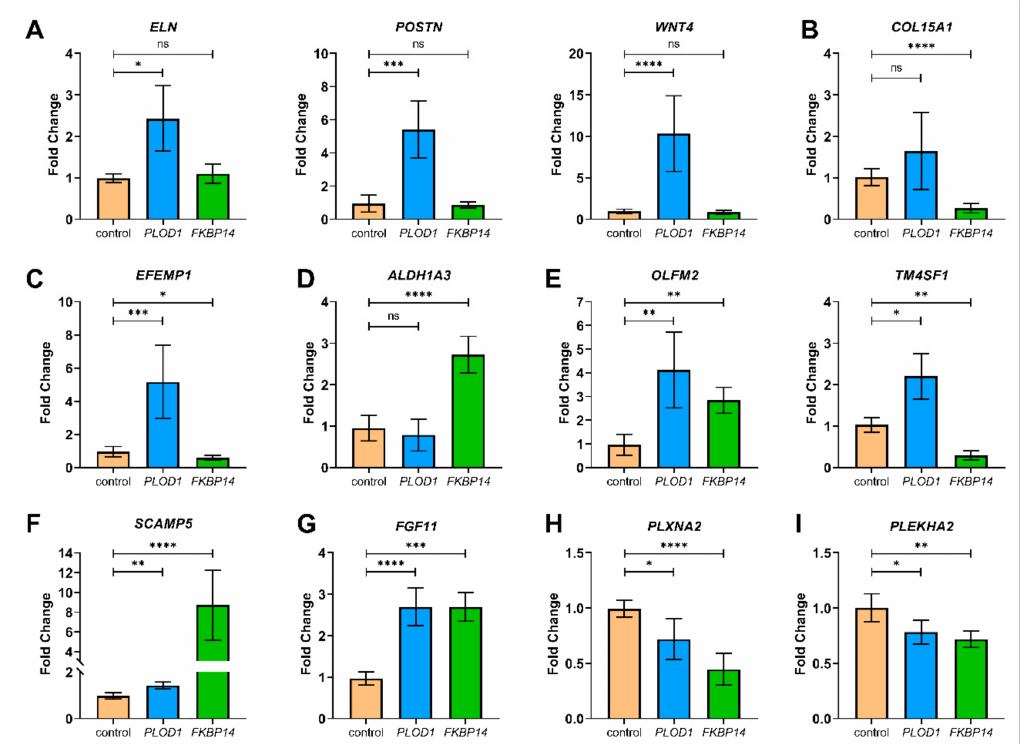
Figure 5. Quantitative RT-PCR was performed to validate the RNA sequencing results. Gene expression levels were measured in four independent replicates per subject, and t-tests were performed (ns = not significant, * = p < 0.05, ** p < 0.005, *** p < 0.0005, **** p < 0.0001). Data are expressed as mean ±